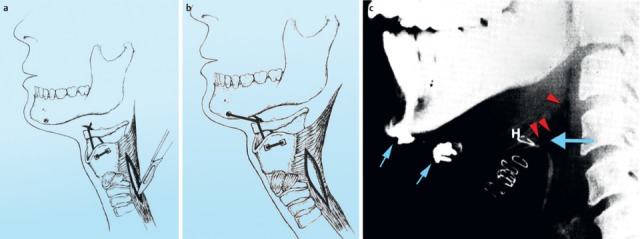
a – extension of the transcervical myotomy of the cricopharyngeal muscle (about 4 cm) with protection of the inferior laryngeal nerve with laryngo-hyoidopexy. The myotomy should be extended in a cranial and caudal direction, all muscle fibers have to be transsected in the area of the myotomy; b – additionally to myotomy, a suspension suture is placed through the mandible in order to draw the laryngohyoid complex under the base of the tongue for protection; c – 43-year-old patient after surgery of an ependymoma of the 4th ventricle. After myotomy, laryngo-hyoido-mentopexy was performed. The small blue arrows show osteosynthesis plates of the hyoido-mentopexy. The blue arrow shows the laryngeal vestibule protected by the base of the tongue. The red arrow heads show soft part opacification of the base of tongue. H = hyoid.